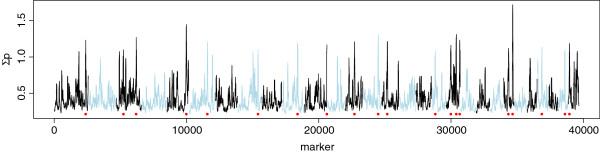
Sum of posterior inclusion probability (∑p) across the genome. Selected QTL are indicated with red dots.